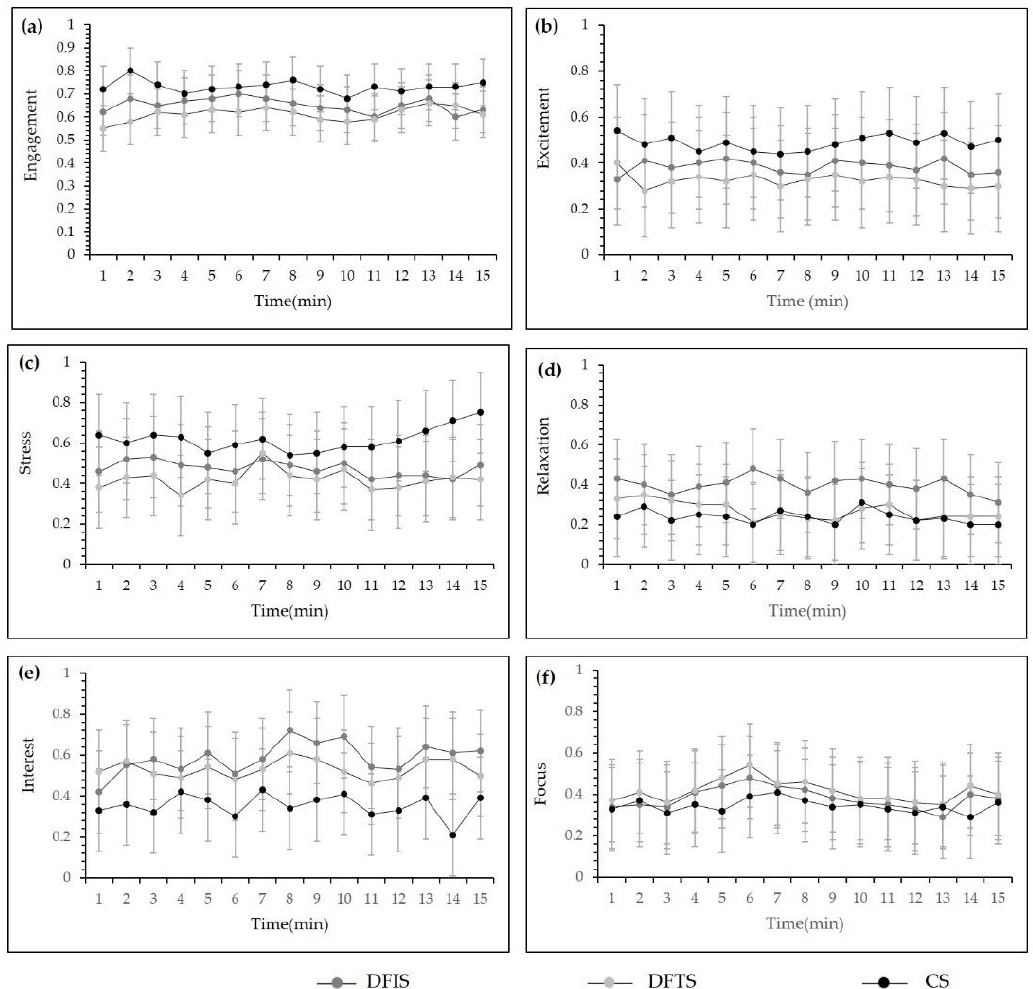
Figure 5. Neural emotional parameter values for the three stimulating environments ( n = 120; mean ± SD; * p < 0.05; ** p < 0.01; verified by a paired t test, DFIS: deciduous forest interior setting; DFTS: deciduous forest trail setting; CS: city setting).